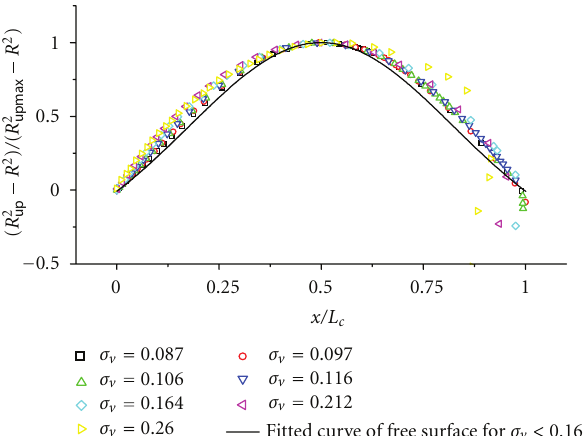
Figure 12: Universal profiles of the lower surface of the cavity at di ff erent σ v , h/H = 0 .